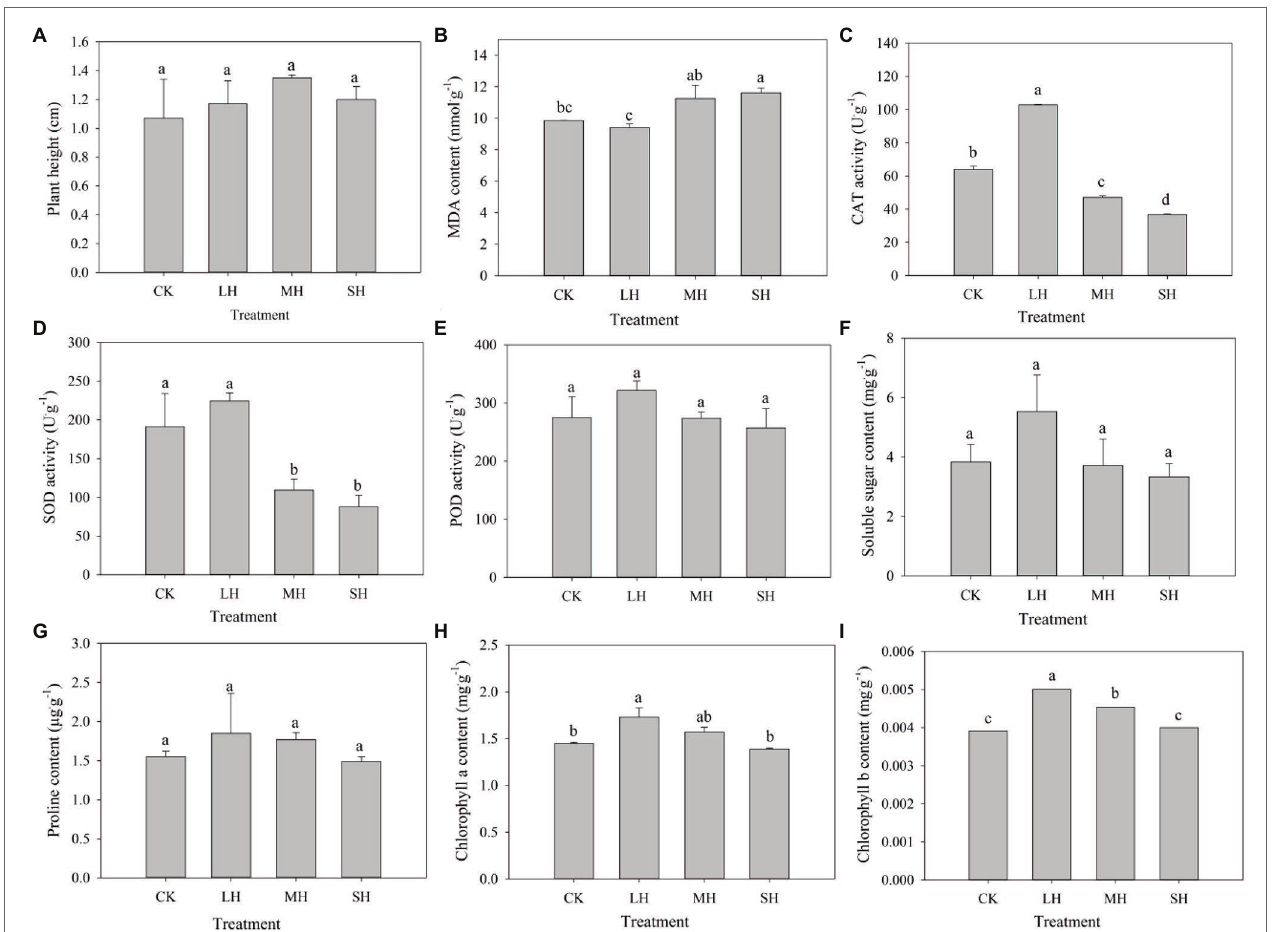
FIGURE 1 | Plant height and physio-biochemical characteristic changes in Paspalum wettsteinii under high-temperature stress. Values are means ± SEs ( n = 3). The different lowercase letters for each treatment are significant at least significant difference (LSD) test at p < 0.05. Effects of drought stress on (A) plant height, (B) MDA content, (C) CAT activity, (D) SOD activity, (E) POD activity, (F) soluble sugar content, (G) proline content, (H) chlorophyll a content, and (I) chlorophyll b